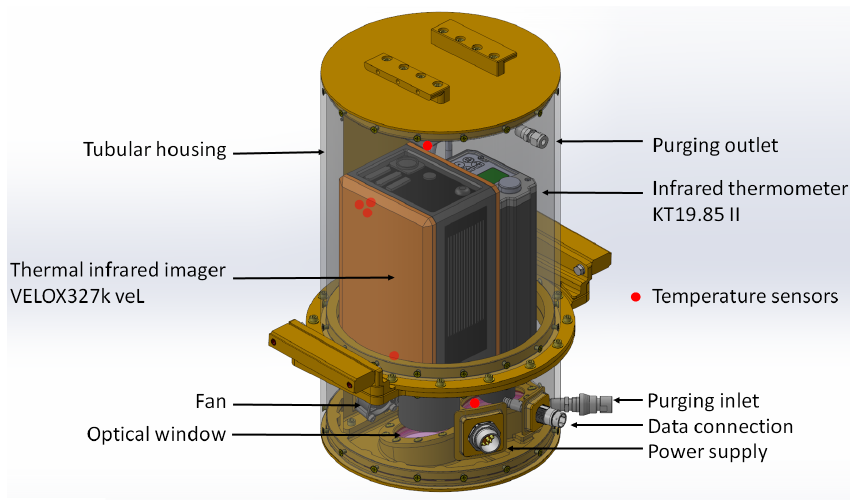
Figure 1. Schematic of the cylindrical housing of VELOX. Only the main components of the system are labelled.